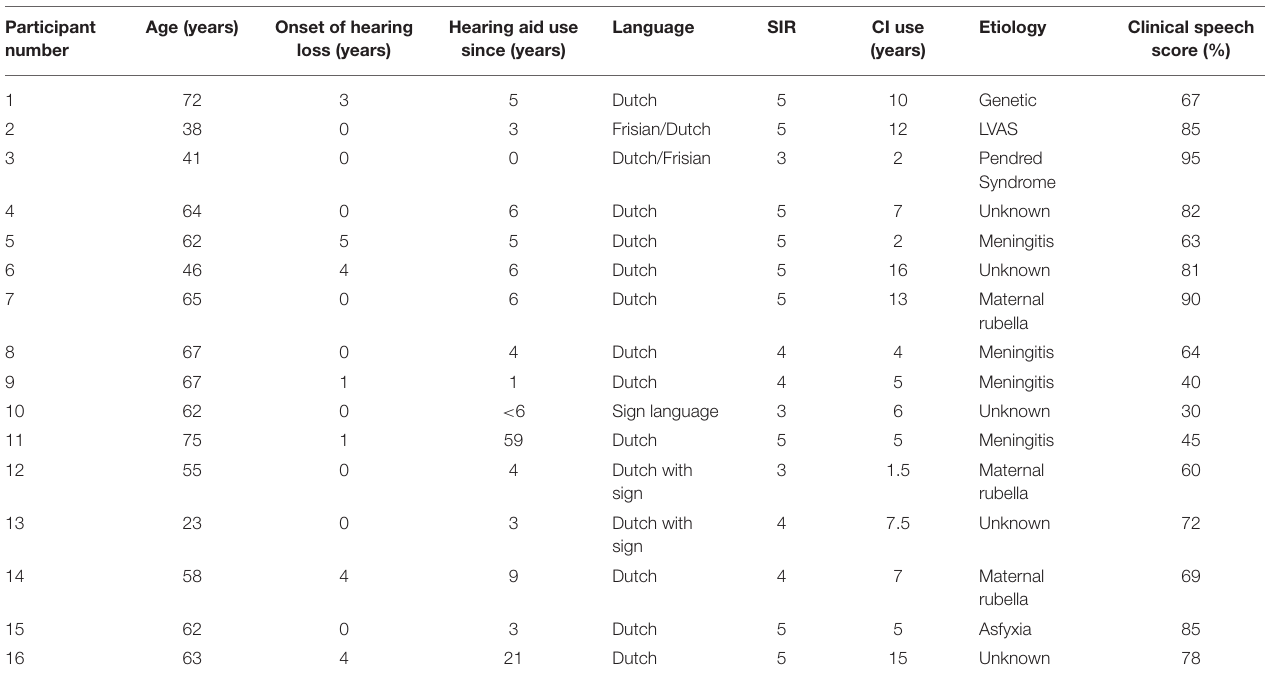
TABLE 1 | Participant details of the EDLI CI